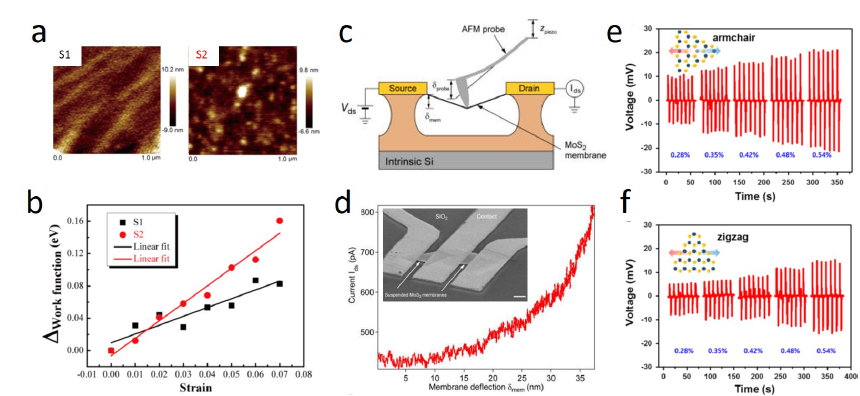
Figure 6. ( a ) AFM images of graphene with (S1) and without (S2) ripples; ( b ) Work function variation of graphene with (S1) and without (S2) ripples as a function of uniaxial strain measured by KPFM. (adapted from [129]); ( c ) Schematic drawing of the setup for direct current electrical characterization of suspended channel MoS 2 devices under strain. The suspended atomically thin membrane (see inset in d) is deformed at the center using an AFM probe; ( d ) Plot of the current vs. membrane deformation measured when a voltage is applied between source and drain electrodes (adapted from [130]). Output voltage obtained from a monolayer MoS 2 as a function of applied strain applied along the armchair direction ( e ) and the zigzag direction ( f ) (reproduced from